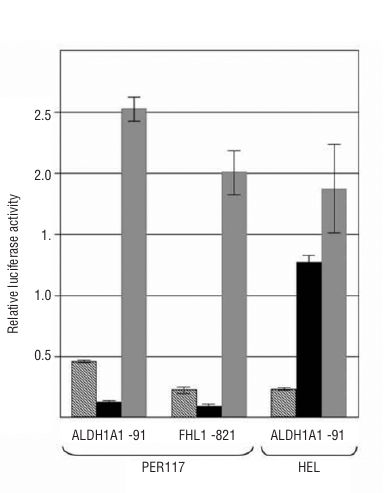
Figure 2. Activity of the human ALDH1A1 promoter and its differential regulation by TLX1. (A) ALDH1A1 pro- moter activity in the hematopoietic cell lines PER-117 and HEL. Luciferase activ- ity expressed as fold-change over the pro- moter-less pGL3-Basic vector after nor- malizing the luciferase signals to a β - galactosidase transfection control. The indicated ALDH1A1 promoter deletion constructs were transiently transfected into PER-117 cells (black bars) and HEL cells (gray bars). Deletion of the CCAAT box (-91 Δ CAT construct) abrogates pro- moter activity. The values represent the average of duplicate data points from three independent experiments. (B) The ALDH1A1 promoter is differentially reg- ulated by TLX1 in PER-117 and HEL cells. The indicated ALDH1A1 luciferase reporter constructs were co-electroporat- ed with a TLX1 expression plasmid and β -galactosidase expression plasmid into the cell lines PER-117 (black bars) and HEL cells (gray bars). Transactivation/ repression is shown as the fold-change (on a log2 scale) compared to back- ground levels obtained when an empty expression vector (no TLX1) was co-elec- troporated. Asterisks denote fold changes that were statistically different to zero ( p <0.05). The -91 Δ CAT construct har- bors a deletion of the CCAAT box. (C) Western blot confirming TLX1 protein expression in the transiently transfected PER-117 and HEL cells. U, untransfect- ed controls; T, TLX1 transfected. The faint band observed in the controls is non-specific.